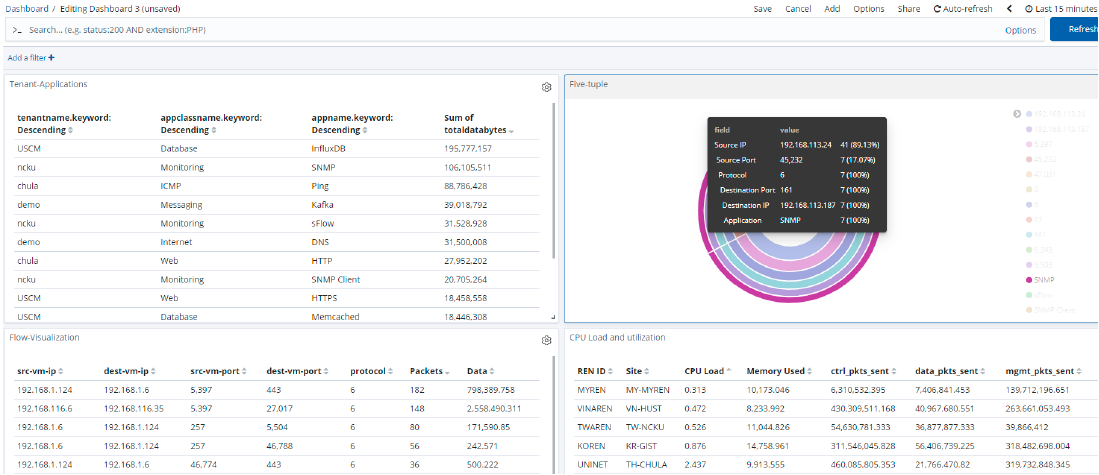
Figure 14. Kibana dashboard to show visualization results from classified visibility data.